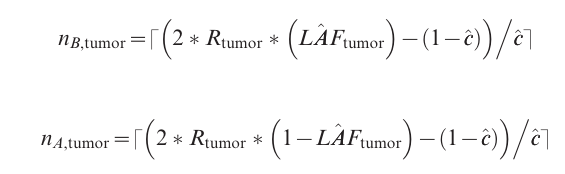
Figure S1 An example showing the effect of denoising